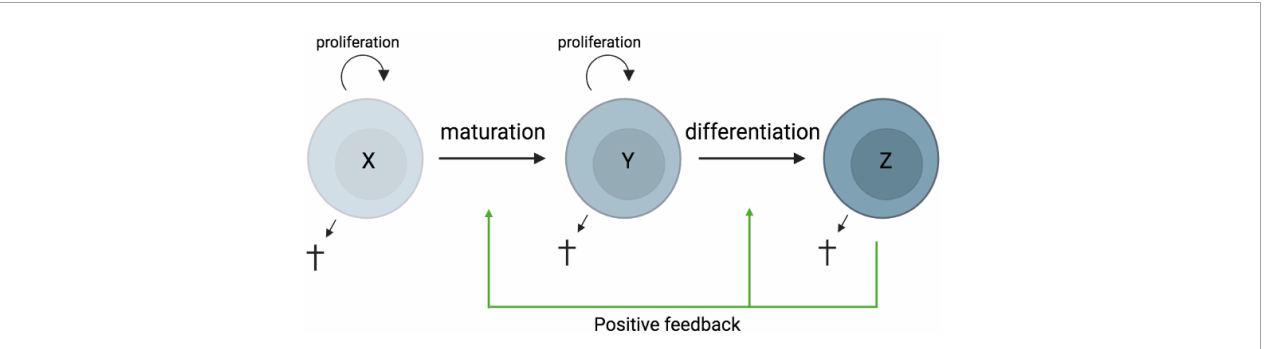
FIGURE 1 Schematic presentation of a simple feedback-controlled balance-of-growth-and-differentiation model. X, progenitor cells; Y, maturing cells; Z, terminally differentiated